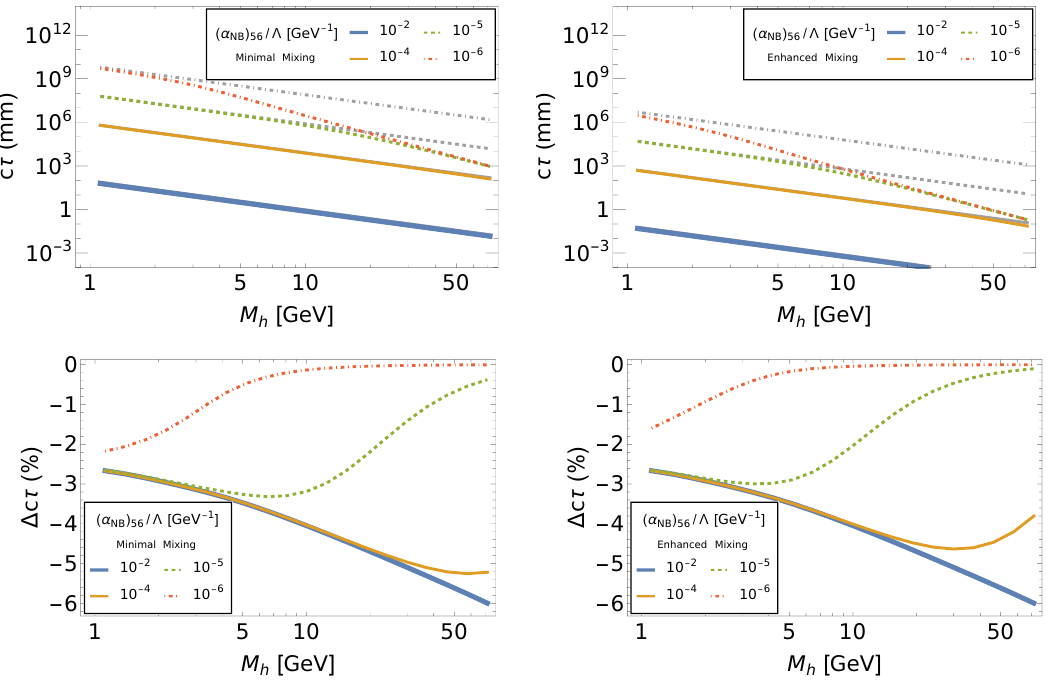
Figure 3 . Top panels: heavy neutrino decay length. Gray lines indicate the expected decay length when considering only two-body decays. Bottom panels: difference in decay length when performing the full calculation, versus including only N → νγ and the standard Seesaw three-body decays. Left: choice of parameters as in figure 1. Right: the same, but with enhanced sterile-light